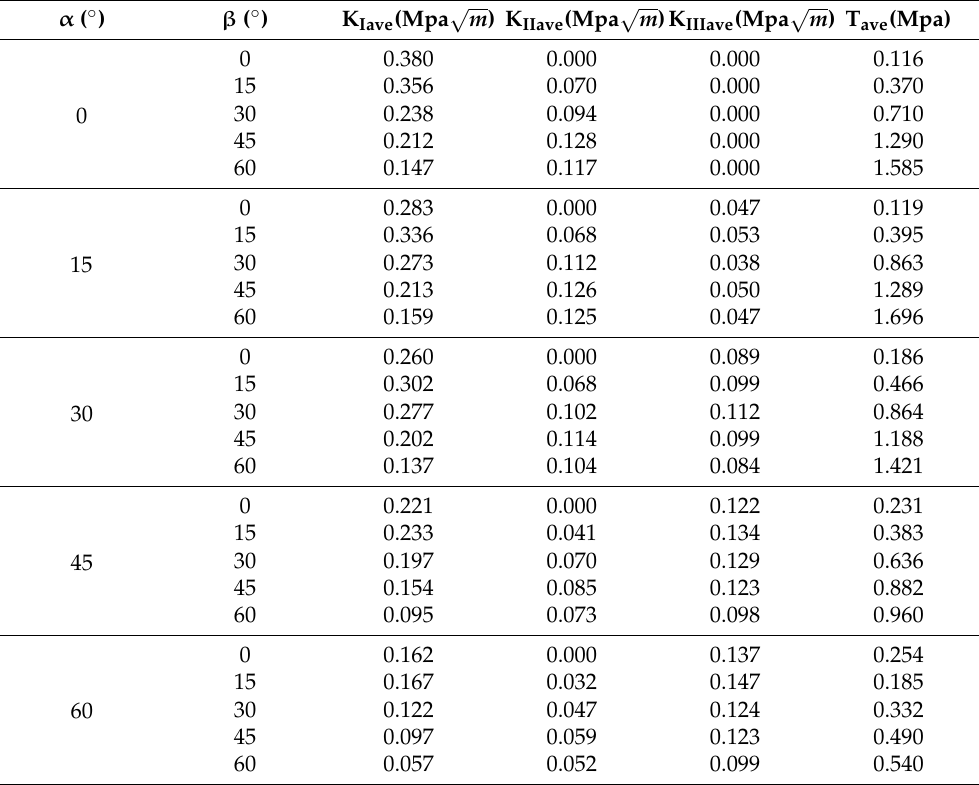
Table A2. The SIFs and T-stresses of experimental fracture results obtained for the tested sandstone material under different loading modes.